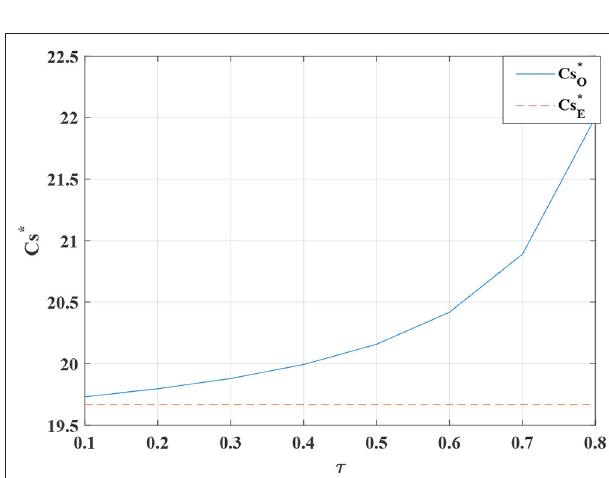
FIGURE 16 | The influence of τ on the optimal consumer